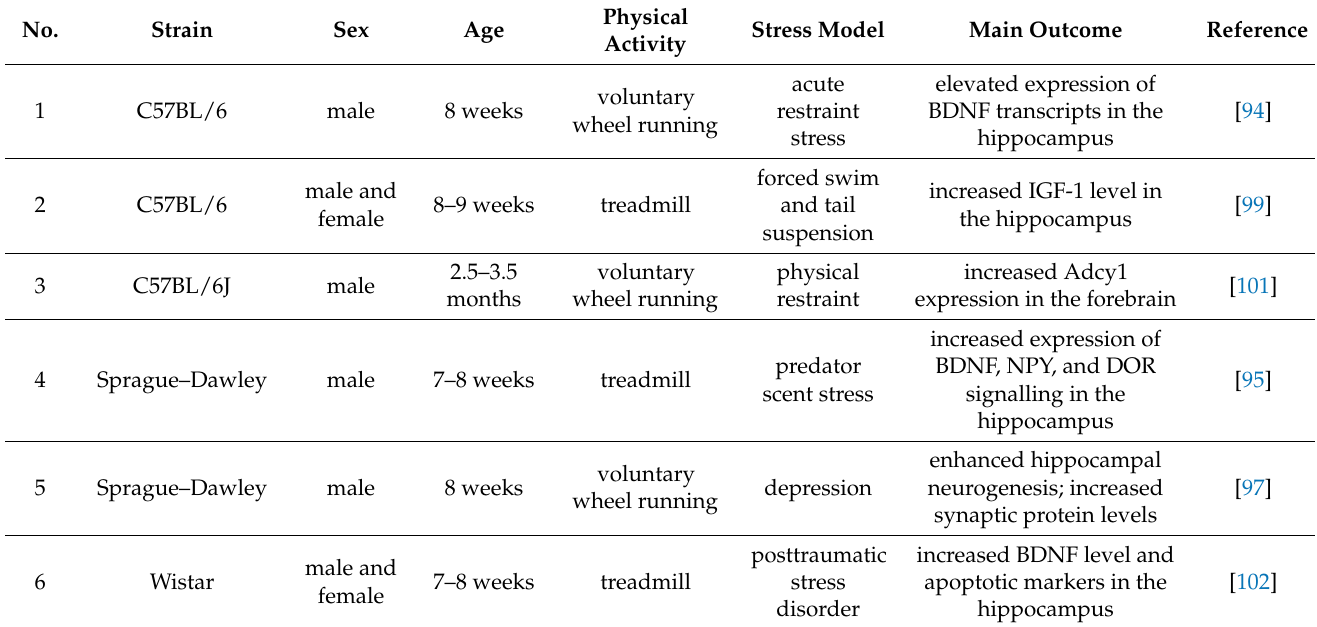
Table 3. Summary of animal research focusing on neurotrophic